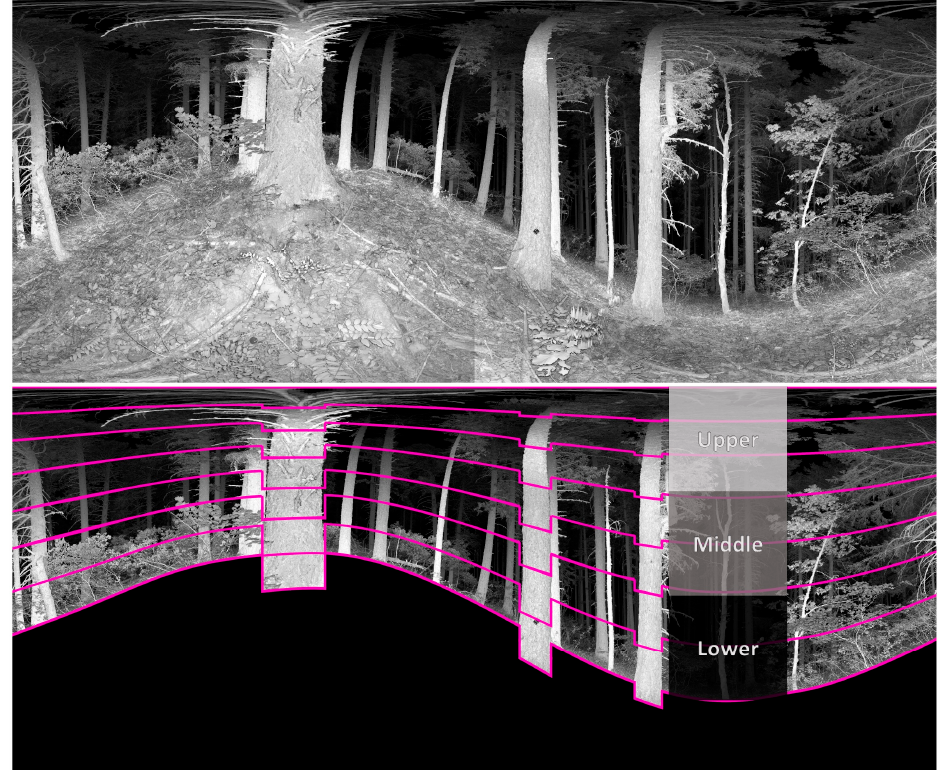
Figure 3. Conceptual illustration of the process used to identify vertical layers and remove the ground from the raster images. The raster data had 10,266 columns and each column was divided into 100 sections between the top of the image and where the column hit the ground. In this figure there are 8 sections drawn in magenta to illustrate how each column was subdivided into 100 sections contoured to the hill slope, accounting for trees extending below the hillslope horizon, and excluding returns from the ground. The upper, middle, and lower sections of the scan are denoted to help with conceptualizing structural signatures.